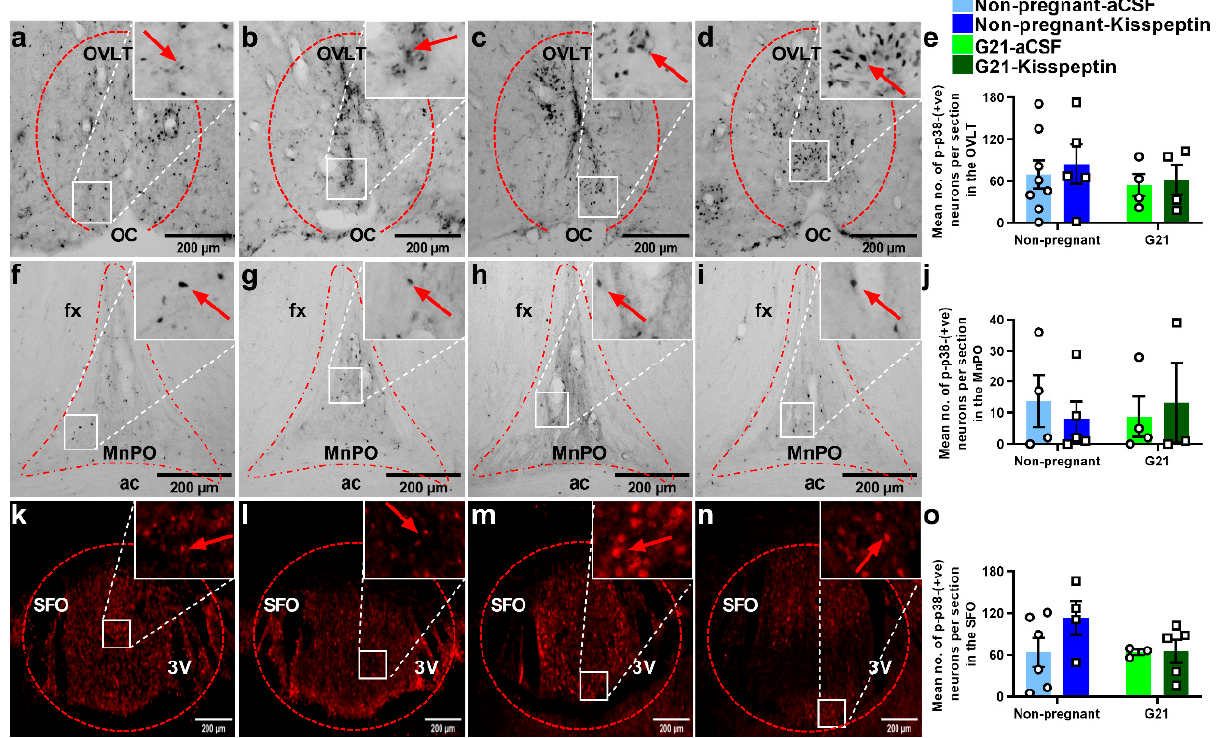
Figure 8. Kisspeptin does not affect p-p38 expression in OVLT, MnPO or SFO neurons of non-pregnant and G21 rats. Photomicrographs of coronal sections containing OVLT ( a – d ), MnPO ( f – i ) and SFO ( k – n ), within the red dotted area, showing p-p38-positive neurons in non-pregnant rats ( a , b , f , g , k , l ) and G21 rats ( c , d , h , i , m , n ) after ICV administration of aCSF ( a , c , f , h , k , m ) or kisspeptin (2 µ g in 2 µ L; b , d , g , i , l , n ). Red arrows point to representative p-p38 labelling. Mean ( ± SEM) number p-p38-positive neurons per section in the ( e ) OVLT (RS: F (1,1) = 0.601, p = 0.448; T: F (1,1) = 0.231, p = 0.636; RS × T: F (1,2) = 0.019, p = 0.890, two-way ANOVA) of non-pregnant (aCSF-treated, n = 8, kisspeptin-treated, n = 5) and G21 rats (aCSF-treated, n = 4, kisspeptin-treated, n = 4), ( j ) MnPO (RS: F (1,1) = 0.00007, p = 0.993; T: F (1,1) = 0.003, p = 0.952; RS × T: F (1,2) = 0.408, p = 0.534, two-way ANOVA) of non-pregnant (aCSF-treated, n = 4, kisspeptin-treated, n = 5) and G21 rats (aCSF-treated, n = 4, kisspeptin-treated, n = 3) and ( o ) SFO (RS: F (1,1) = 1.31, p = 0.271; T: F (1,1) = 1.50, p = 0.240; RS × T: F (1,2) = 1.32, p = 0.268, two-way ANOVA) of non-pregnant (aCSF-treated, n = 6, kisspeptin-treated, n = 4) and G21 rats (aCSF-treated, n = 3, kisspeptin-treated, n = 5). ac anterior commissure, fx fornix, MnPO median preoptic nucleus, OC optic chiasma, OVLT organum vasculosum lamina terminalis, SFO subfornical organ, 3V third ventricle, scale bar = 200 µ